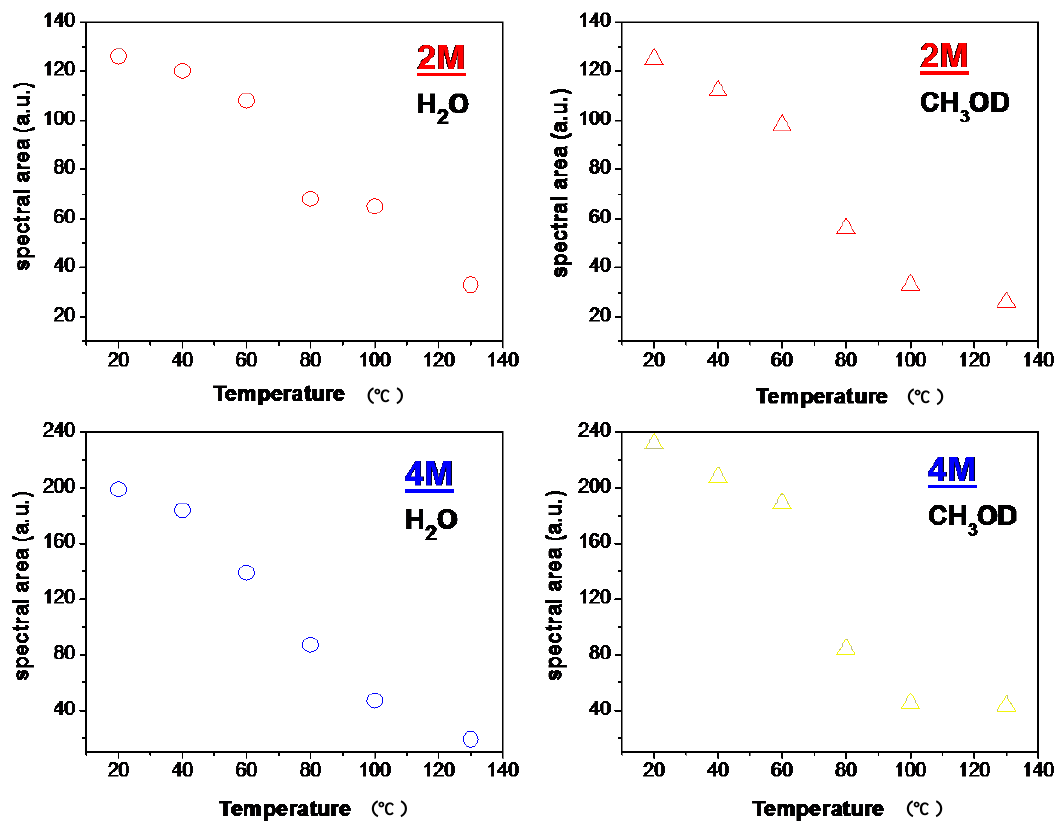
Figure 7. Plots of the spectral area vs. temperature of water and methanol in both 2 M and 4M solutions confined in Lap/Nafion